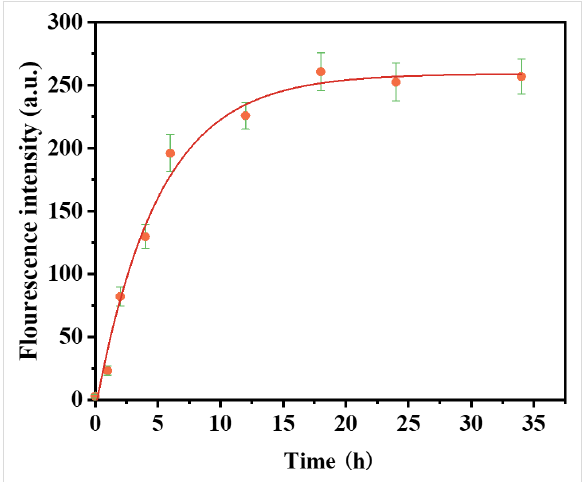
Figure 7: Fluorescence intensity of RGCOOH released from GNPs- GSH-Rh6G2 in the presence of Hg 2+ within 35 h at room temperature in HEPES/CH 3 OH buffer (1:1 (v/v), 50 mM, pH